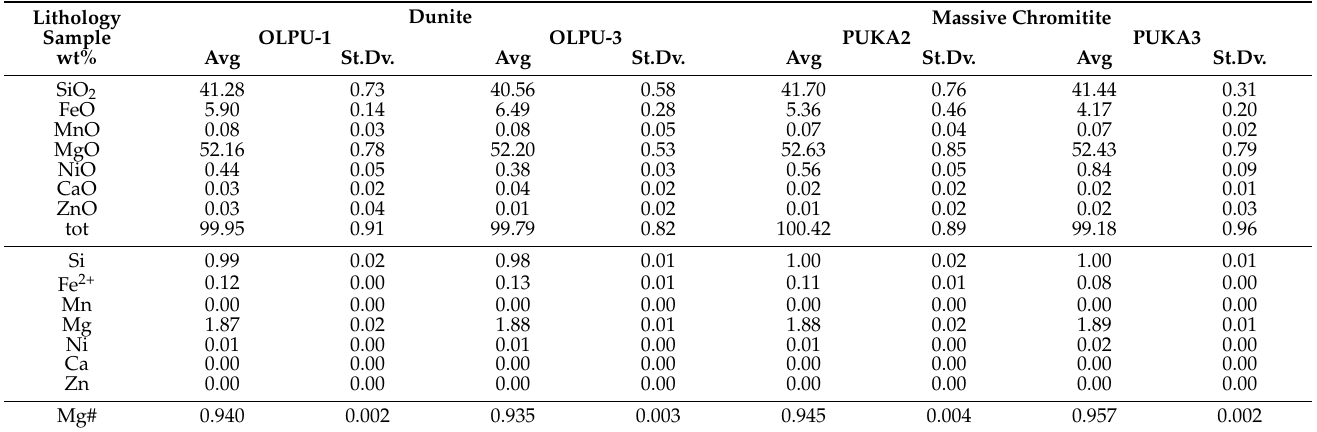
Table 2. Major and minor elements average composition and standard deviation of olivine cores from Iballe dunites and chromitites; Mg# = [Mg/(Mg + Fe 2+